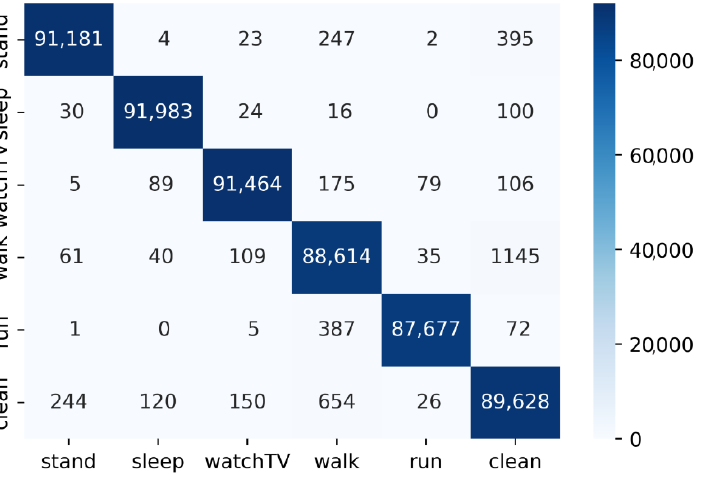
Figure 5. Confusion matrix of the GRU + CA + TA model on the datasets with I.I.D.